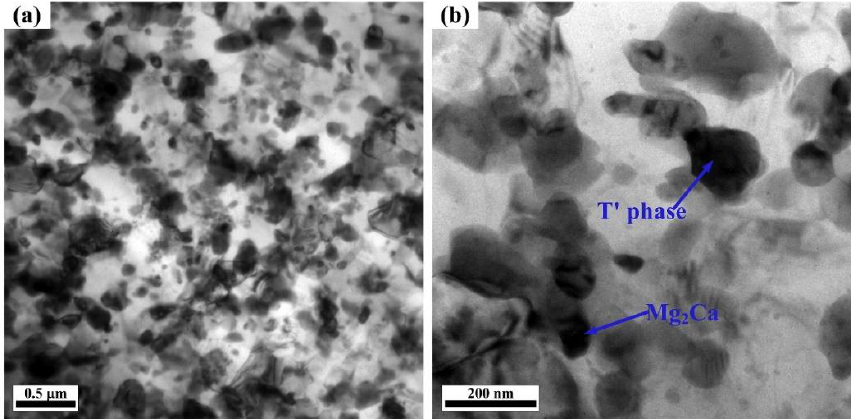
Figure 2. Transmission electron microscope (TEM) images of as-extruded Mg–6Zn–5Ca–3Ce alloy fabricated by RS: ( a ) bright image with low magnification; ( b ) bright image with high magnification. Table 2. Nomenclatures of the physical quantities and abbreviations.